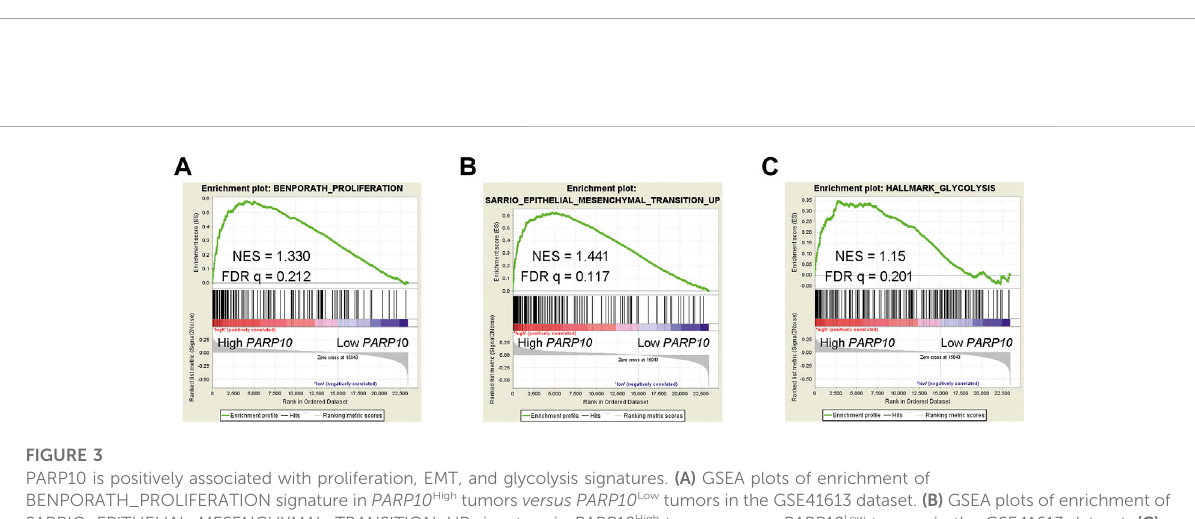
FIGURE 2 Upregulation of PARP10 is associated with poor survival in OSCC patients. (A,B) The protein levels of PARP10 in OSCC and normal oral epithelium tissues were investigated by immunohistochemistry (A) , and the difference in PARP10 expression between the two groups was analyzed usingthe χ 2test (B) . (C,D) Kaplan-Meieranalysiswasperformedtoassesstheassociationbetween PARP10 expressionandtheoverallsurvival (C) and disease-speci fi c survival (D) of OSCC patients in the GSE41613 dataset.